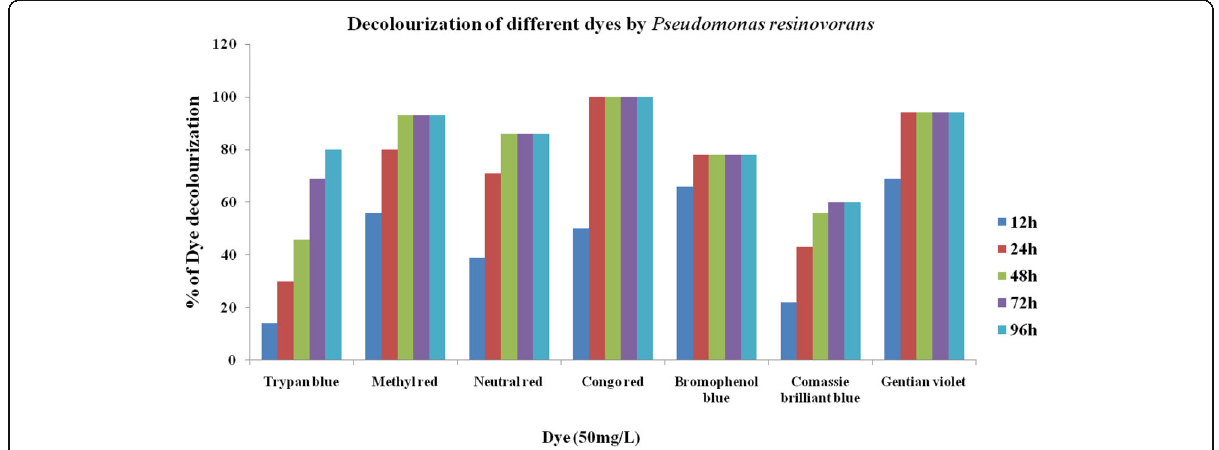
Fig. 5 Decolorization of different dyes by Pseudomonas resinovorans